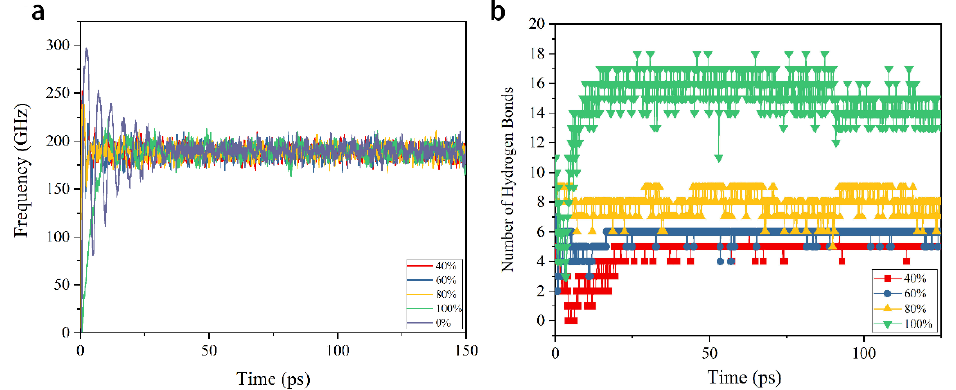
Figure 2. ( a ) The rotation frequency of rotor when pristine CNTs , CNTs with 40%, 60%, 80%, 100% grafted hydroxyl groups are applied. ( b ) The hydrogen bonds in five cases.